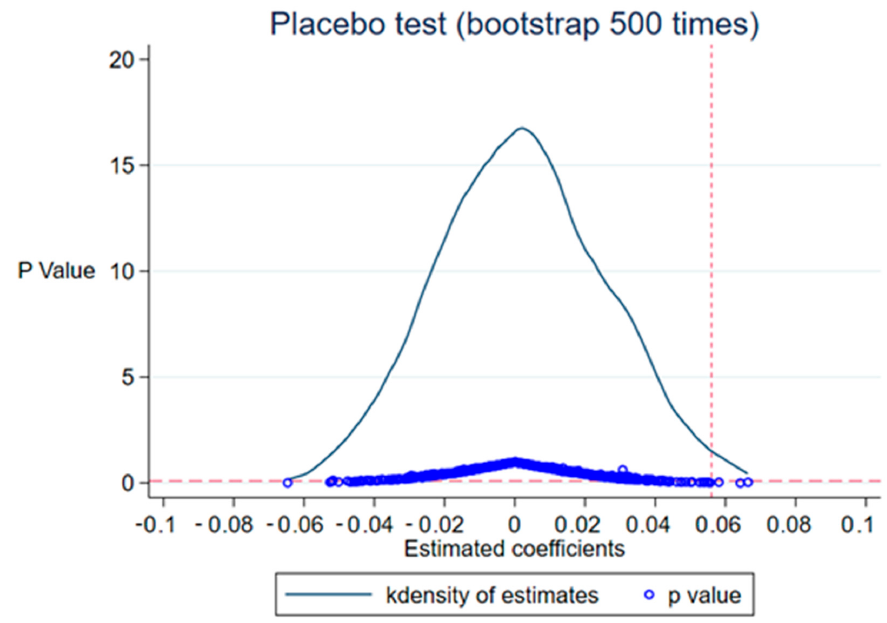
Figure 2. Randomly selected experimental groups.